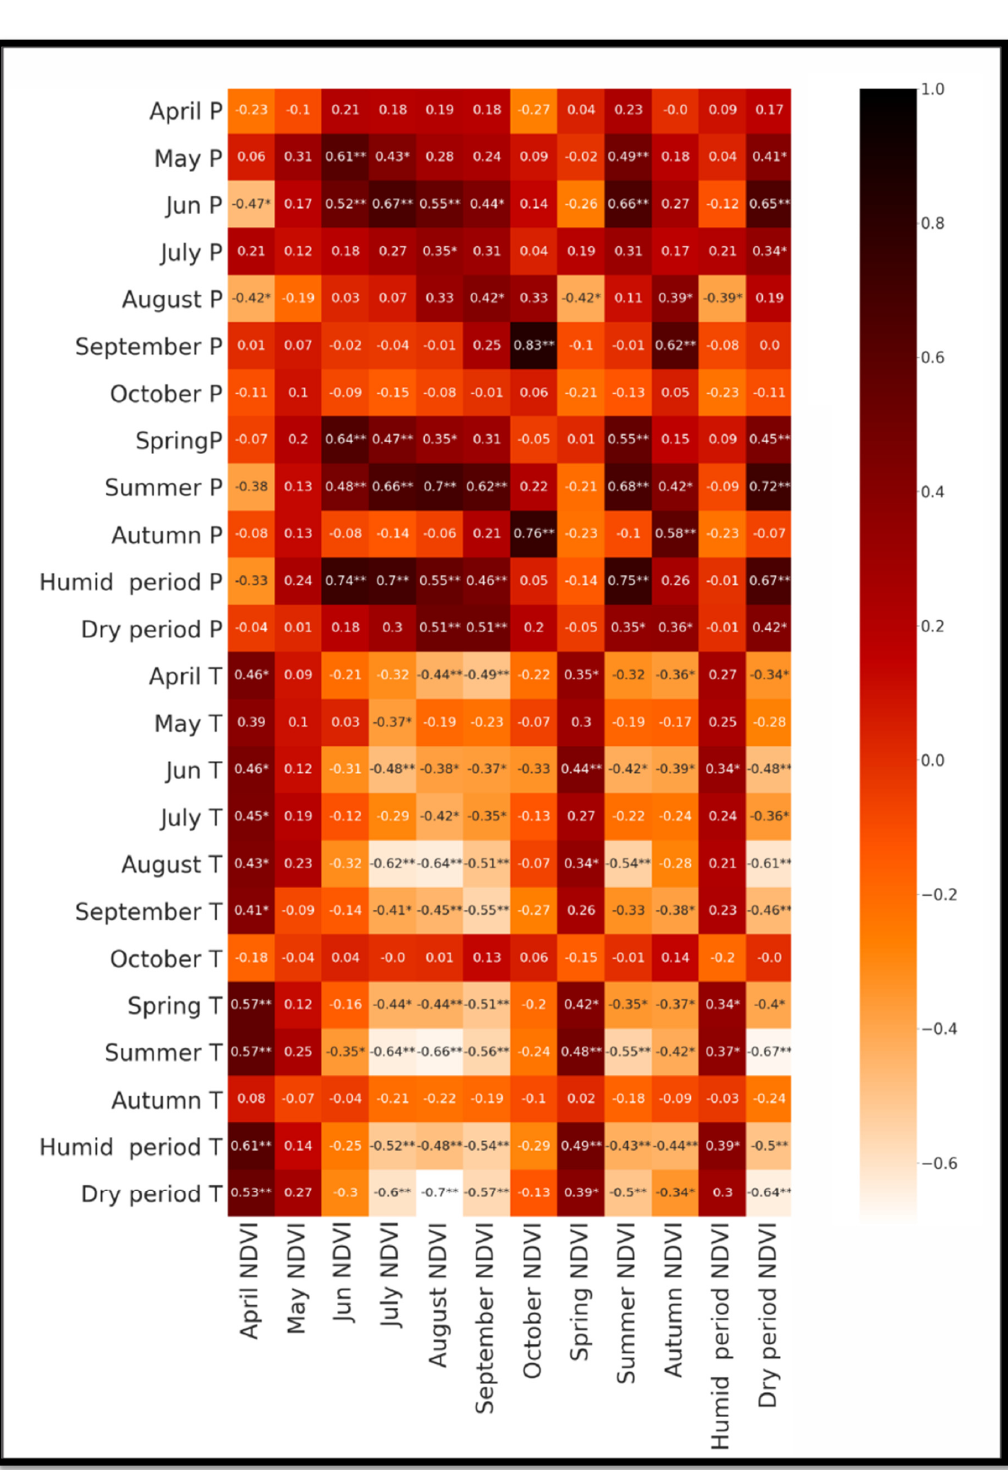
Figure 5. Correlation between averaged monthly and periodic values of temperature, precipitation, and BRDF NDVI for Sisian, with the levels of significance: * − p < 0.05, ** p < 0.01.